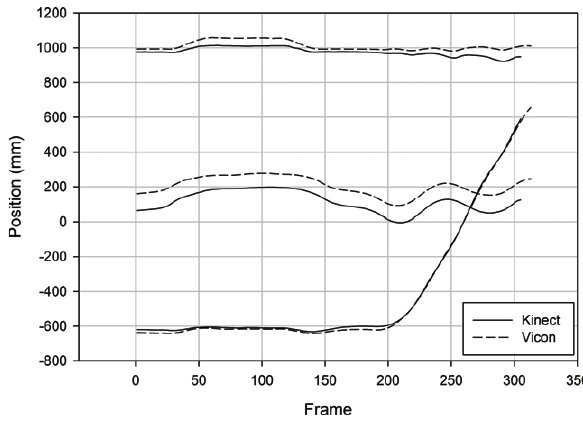
Fig. 7: Graph of center of mass for test 3 ( R 2 x = 0.9997, R 2 y = 0.9909, R 2 z = 0.7232).